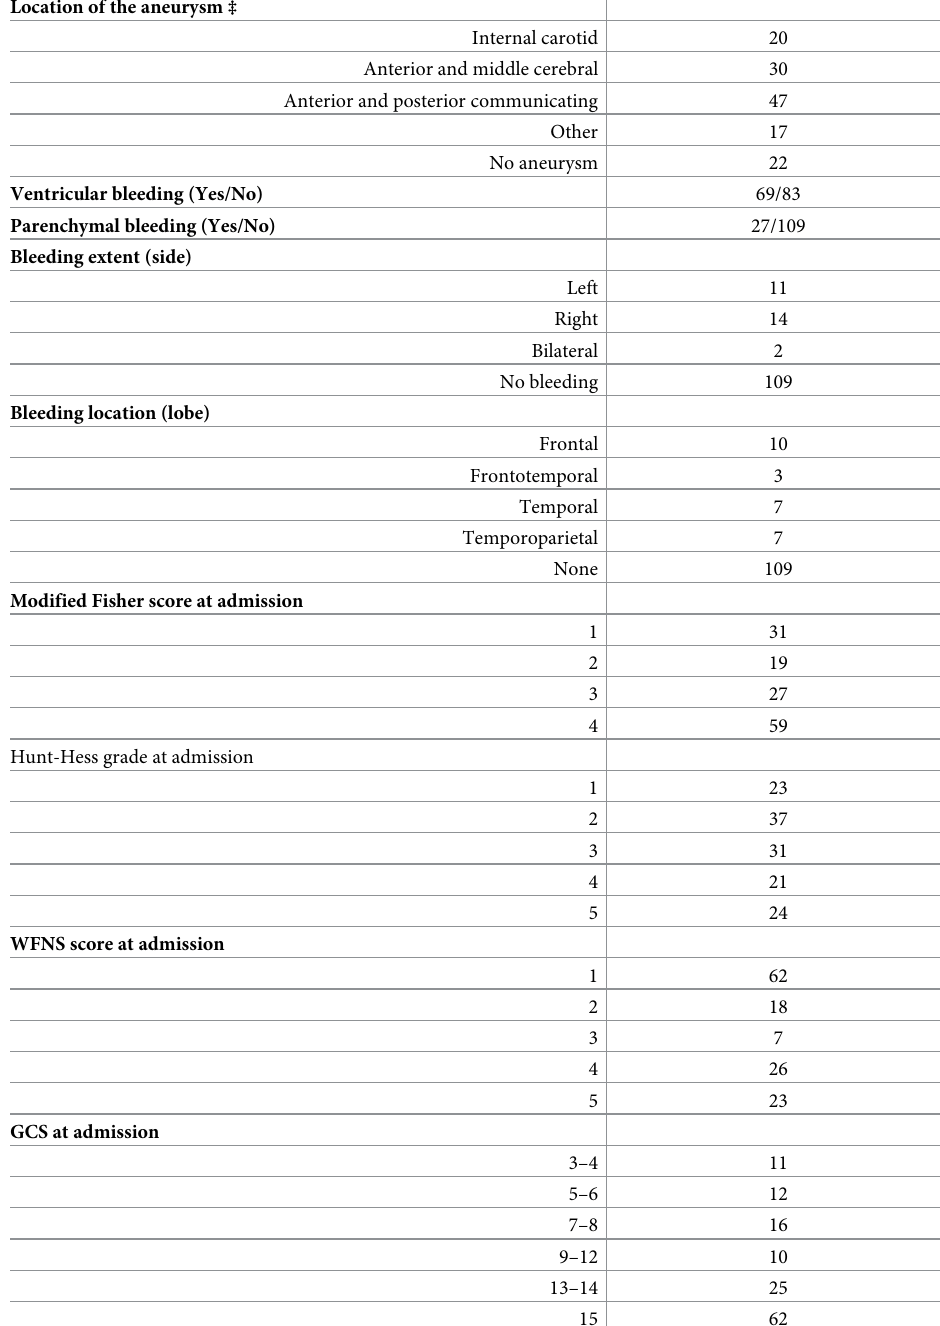
Table 2. Characteristics of subarachnoid hemorrhage in the entire cohort. Location of the aneurysm ‡ Internal carotid 20 Anterior and middle cerebral 30 Anterior and posterior communicating 47 Other 17 No aneurysm 22 Ventricular bleeding (Yes/No) 69/83 Parenchymal bleeding (Yes/No) 27/109 Bleeding extent (side) Left Right